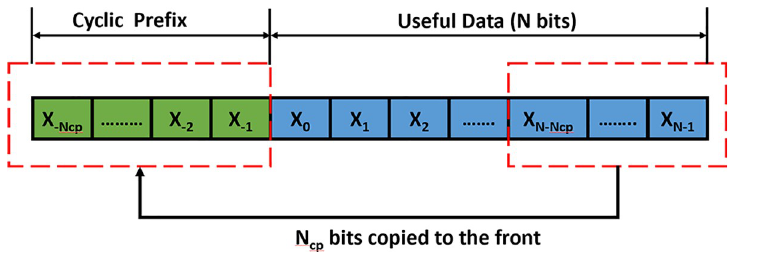
Fig 2. Cyclic prefix property of OFDM communication